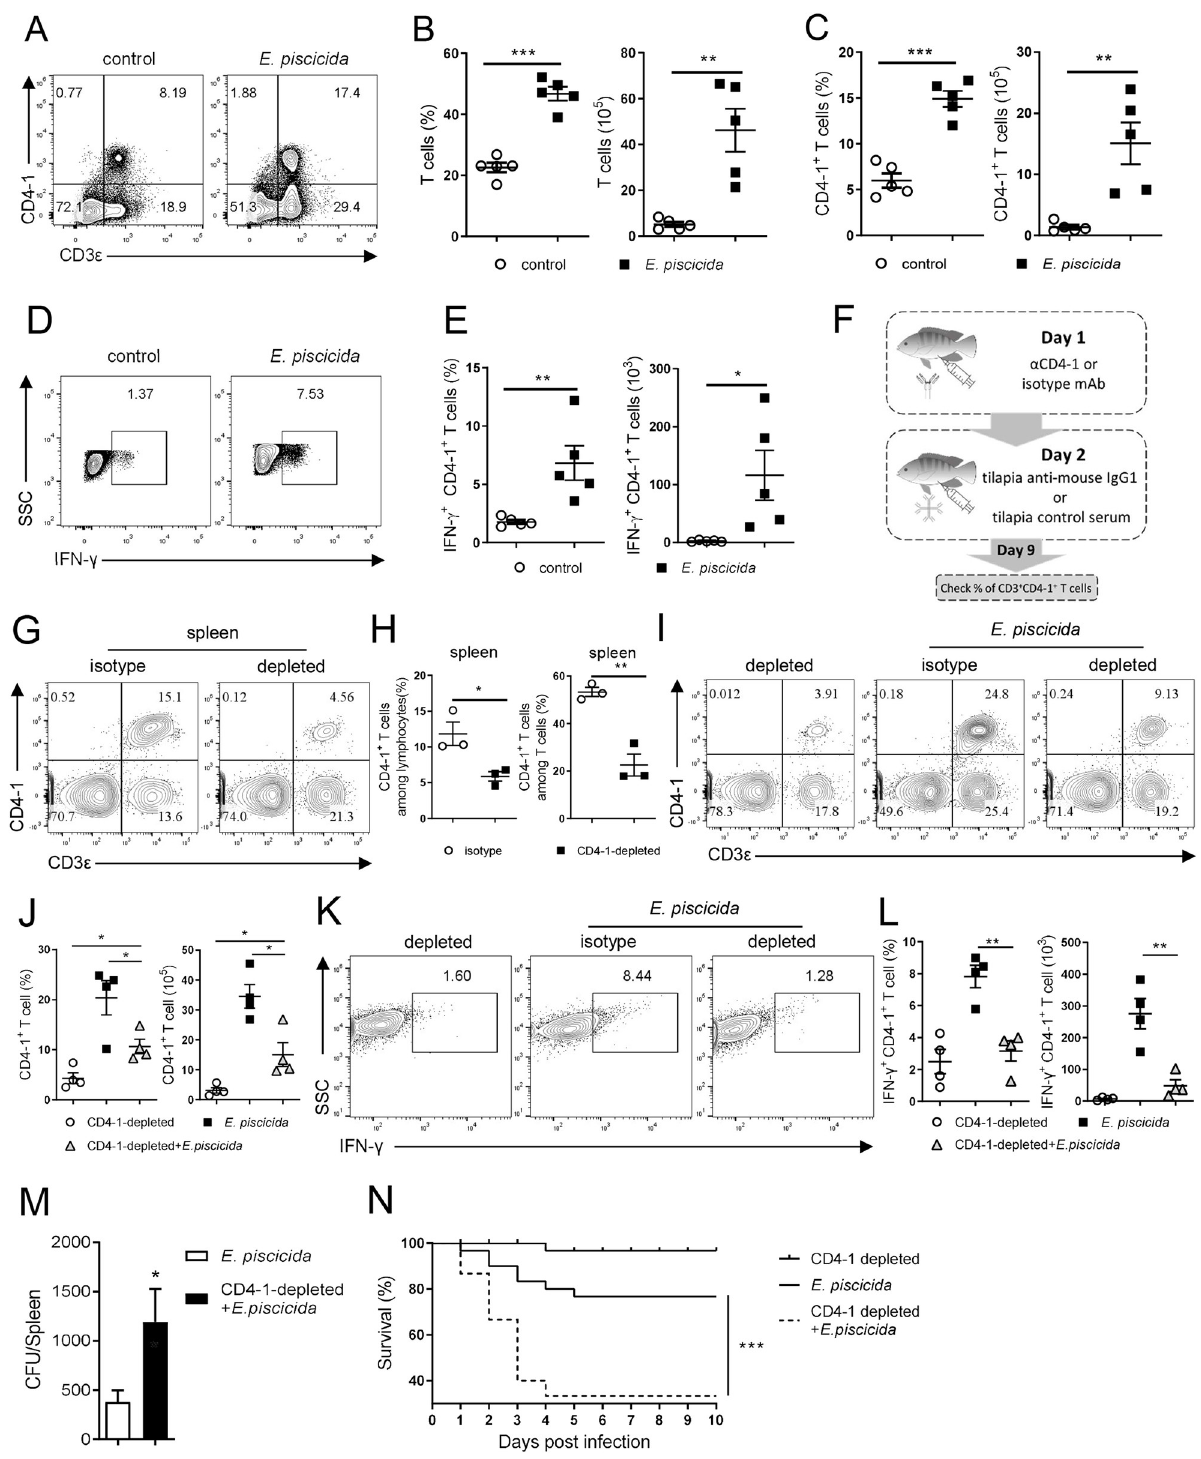
Fig 3. Tilapia Th1 cells are essential for resisting intracellular bacterial infection. (A-E) Tilapia individuals that infected with E . piscicida or uninfected controls were i . p . injected with BFA 6 hours before sacrifice, and spleen lymphocytes were isolated for assays. (A) Flow cytometry showed the cells stained with CD3 ε and CD4-1 mAbs. ( B, C ) Scatter plot figures showed the percentage and absolute numbers of CD3 + T cells (B) and CD3 + CD4-1 + T cells (C) , n = 5. ( D, E ) Representative dot plots ( D ), percentage and absolute numbers ( E ) of IFN- γ + cells in gated CD3 + CD4-1 + T cells, n = 5. (F) Strategy for CD4-1 + cells depletion. (G) Flow cytometry showed the percentage of CD3 + CD4-1 + T cells in spleen lymphocytes of CD4-